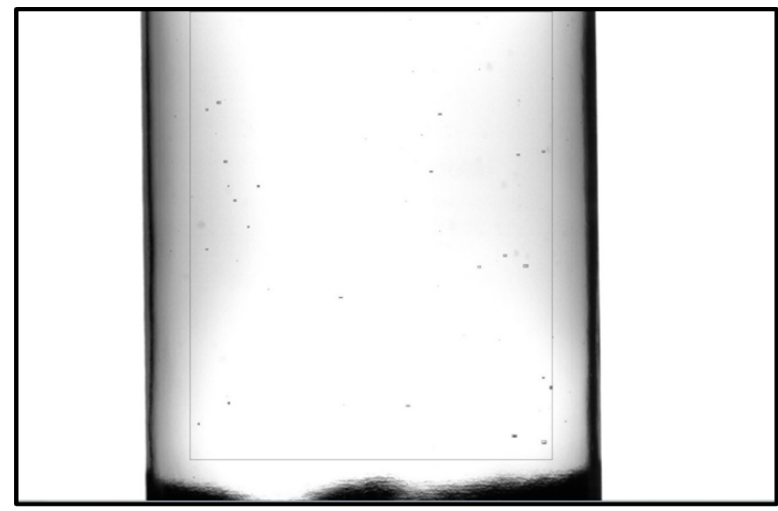
Figure 11. Image of bottle with detected seeds and blisters.